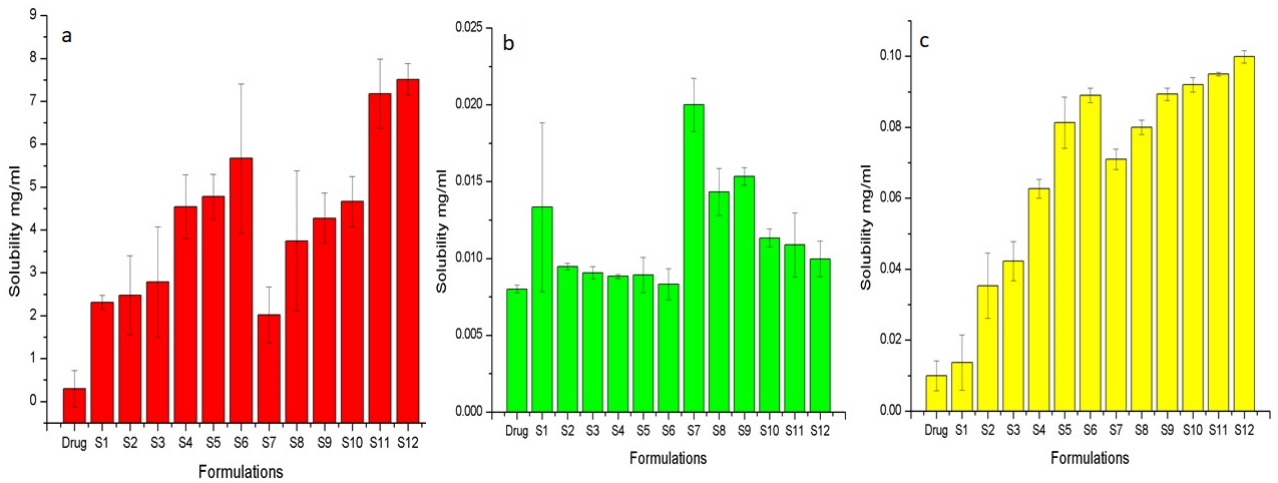
Figure 1. Solubility of drug at ( a ) pH 6.8 (PBS), ( b ) pH 1.2 (0.1 N HCl), and ( c ) distilled